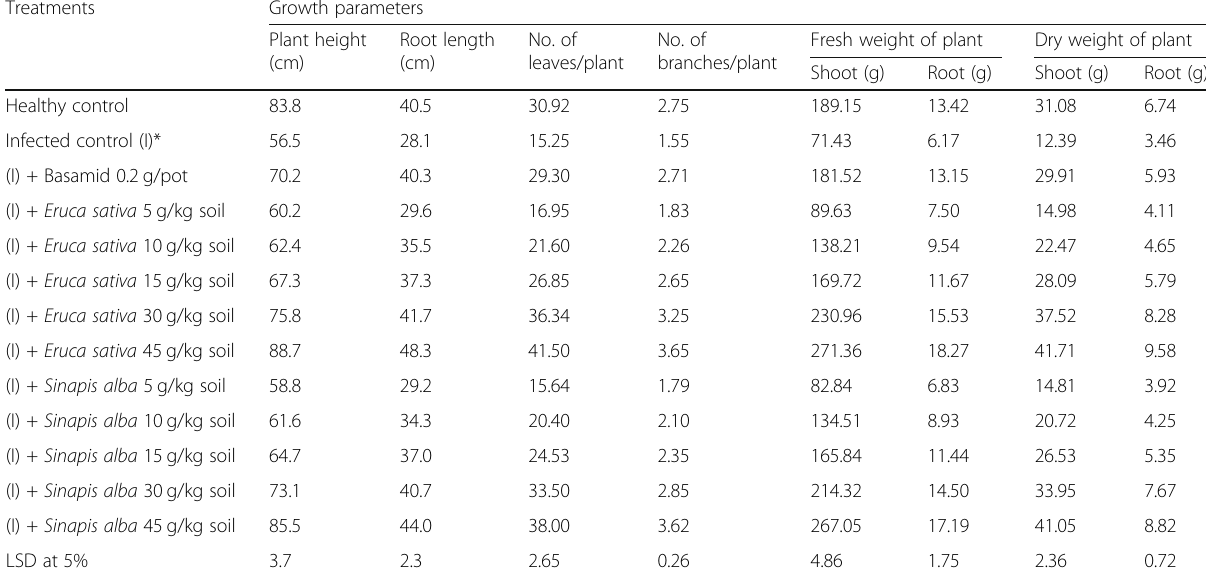
Table 4 Effect of different concentrations of both Eruca sativa L. and Sinapis alba L. seed powder and herbicide Basamid on growth parameters of Lycopersicon esculentum Mill. at 100 days from transplanting. (average of the two seasons) Treatments Growth parameters Plant height Root length No. of No. of Fresh weight of plant (cm) (cm) leaves/plant branches/plant Healthy control